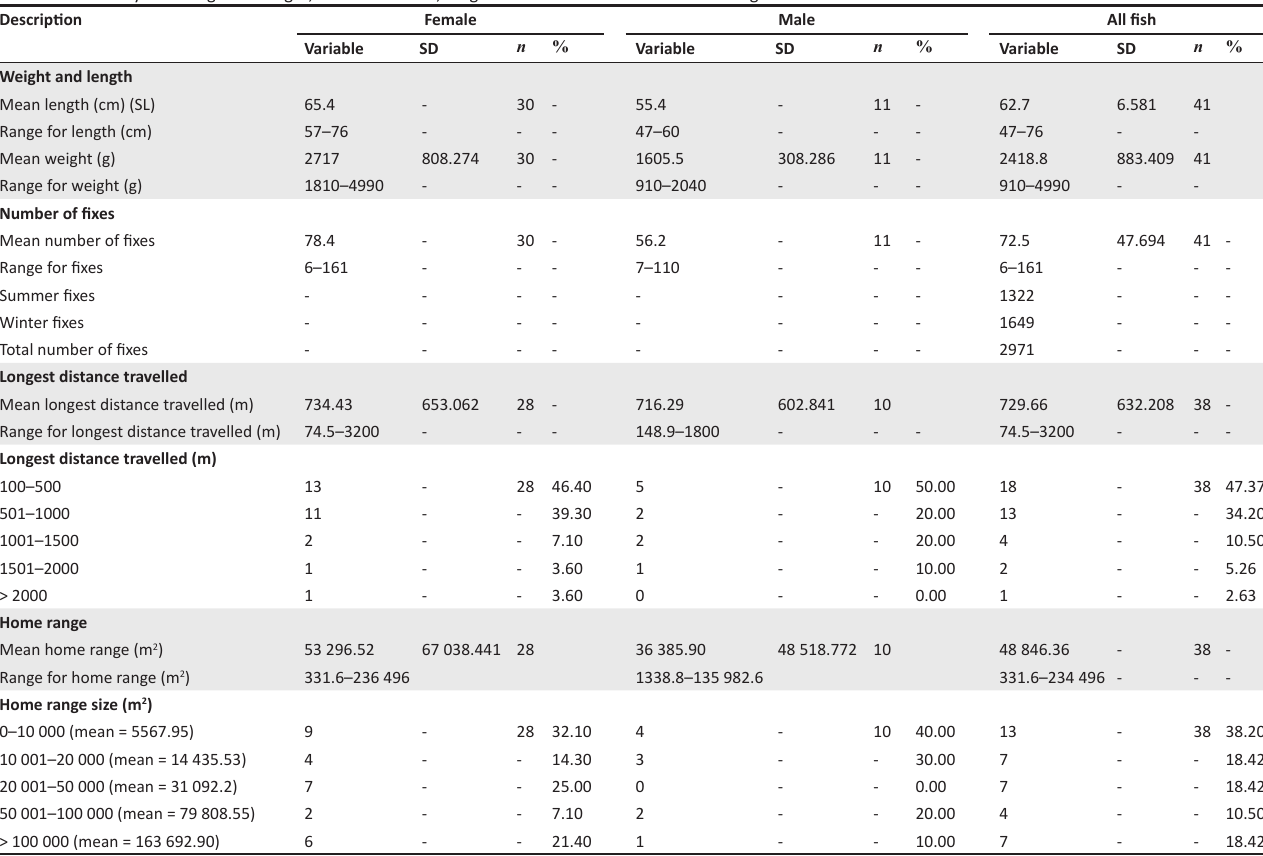
TABLE 2: Summary of average fish length, number of fixes, longest distance travelled and home range.